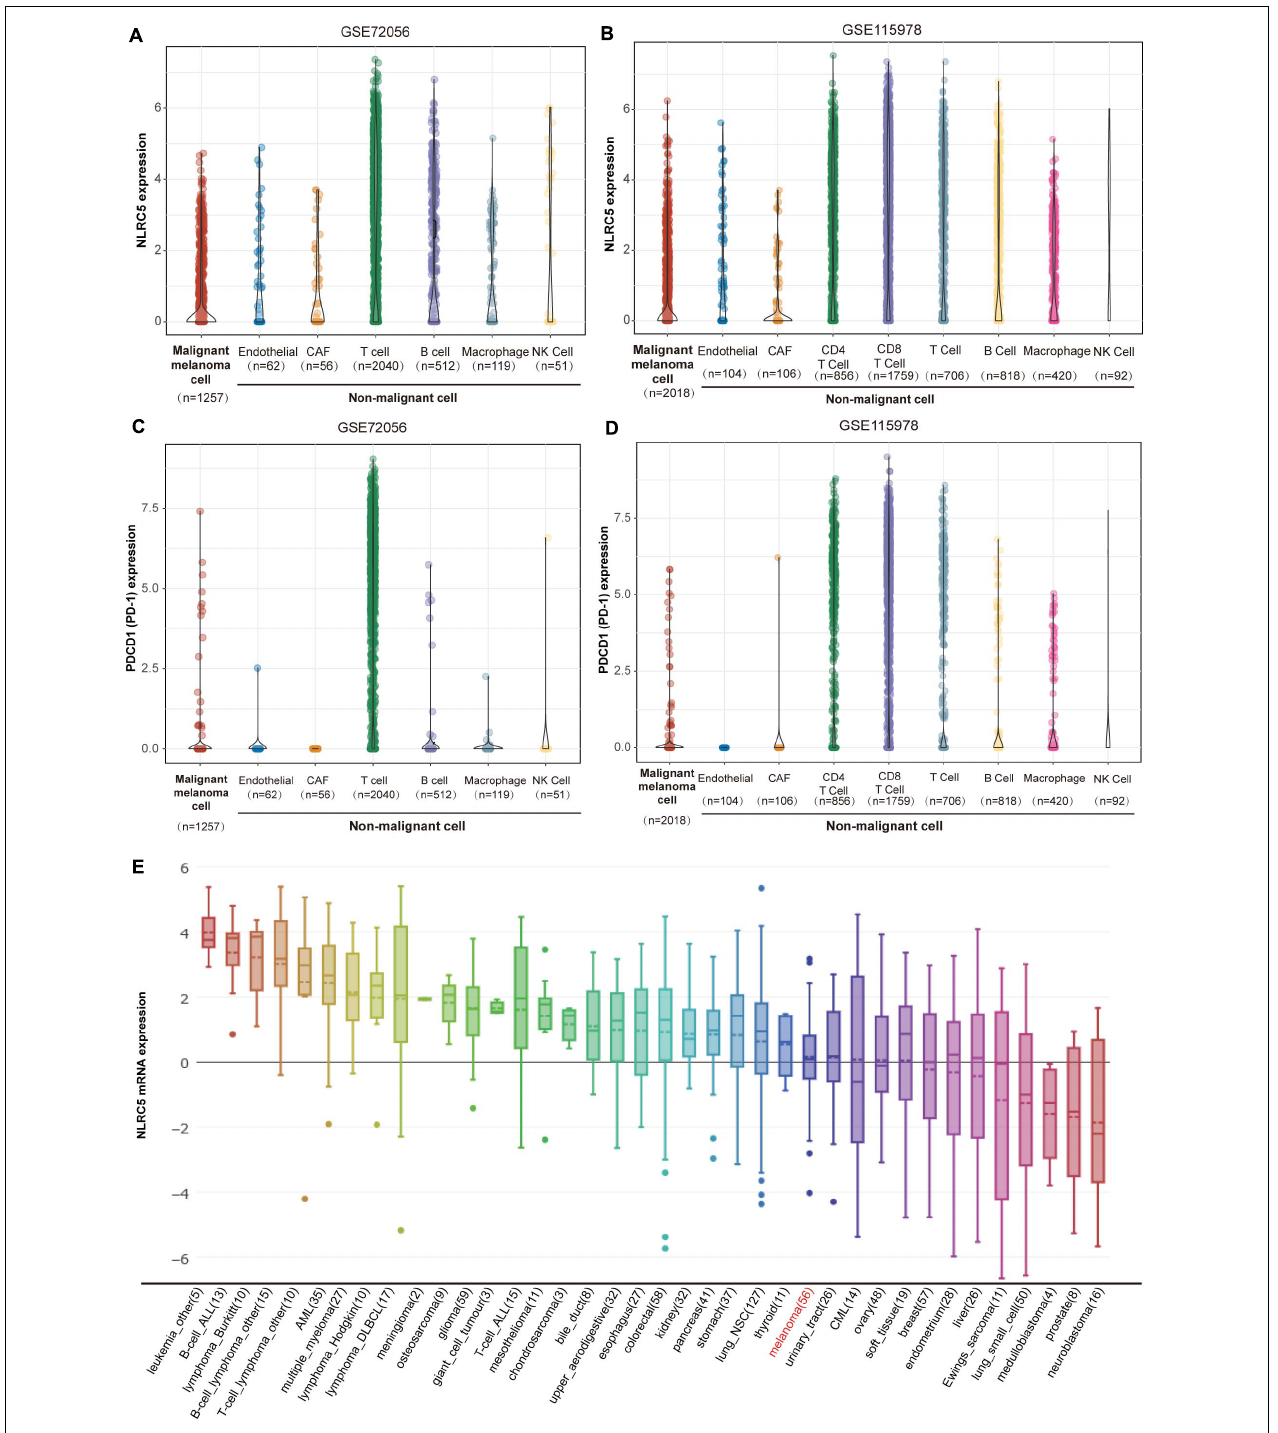
FIGURE 1 | NLRC5 expression in melanoma. (A) NLRC5 mRNA expression in single malignant melanoma cells, endothelial cells, CAFs (cancer-associated fibroblasts), T cells, B cells, macrophages, and NK Cells analyzed from melanoma datasets GSE72096. (B) NLRC5 mRNA expression in single malignant melanoma cells, endothelial cells, CAFs, CD4 + T cells, CD8 + T cells, other kinds of T cells, B cells, macrophages, and NK Cells analyzed from melanoma dataset GSE115978. (C) PDCD1 (PD-1) mRNA expression in single malignant melanoma cells, endothelial cells, CAFs, T cells, B cells, macrophages, and NK Cells was analyzed from melanoma dataset GSE72056. (D) PDCD1 (PD-1) mRNA expression in single malignant melanoma cells, endothelial cells, CAFs, CD4 + T cells, CD8 + T cells, other kinds of T cells, B cells, macrophages, and NK Cells analyzed from melanoma datasets GSE115978. (E) NLRC5 mRNA expression in melanoma cell lines and other kinds of cell lines from the CCLE (Cancer Cell Line Encyclopedia) dataset. The x -axis indicates the kind and number of cell lines.